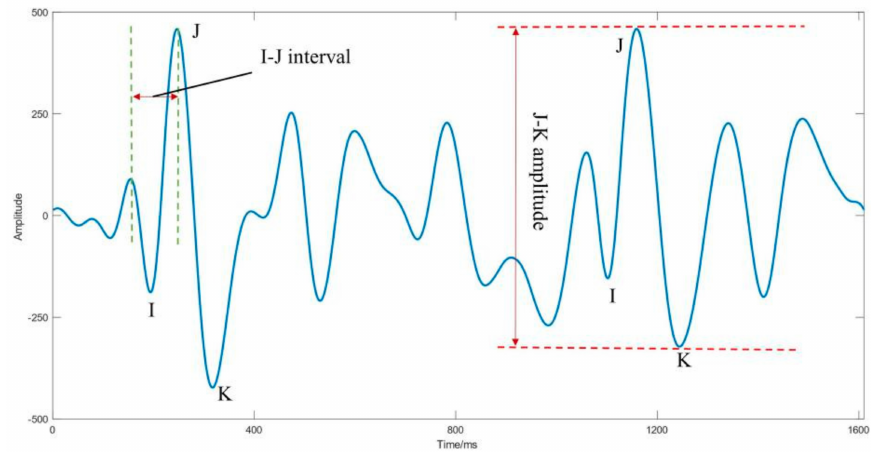
Figure 2. Typical BCG